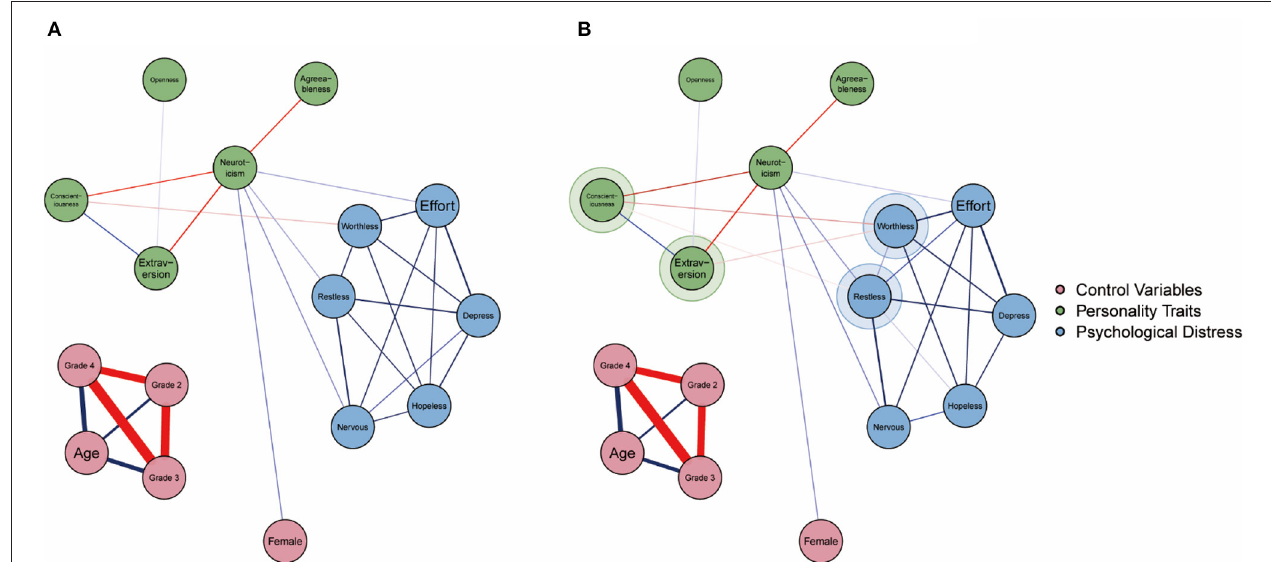
FIGURE 3 | Graphical results of the estimated network models with control variables during college lockdown and after college lockdown. Blue links denote positive associations and red links denote negative associations. The color borders highlighted for nodes in (B) denote new links compared to the (A)